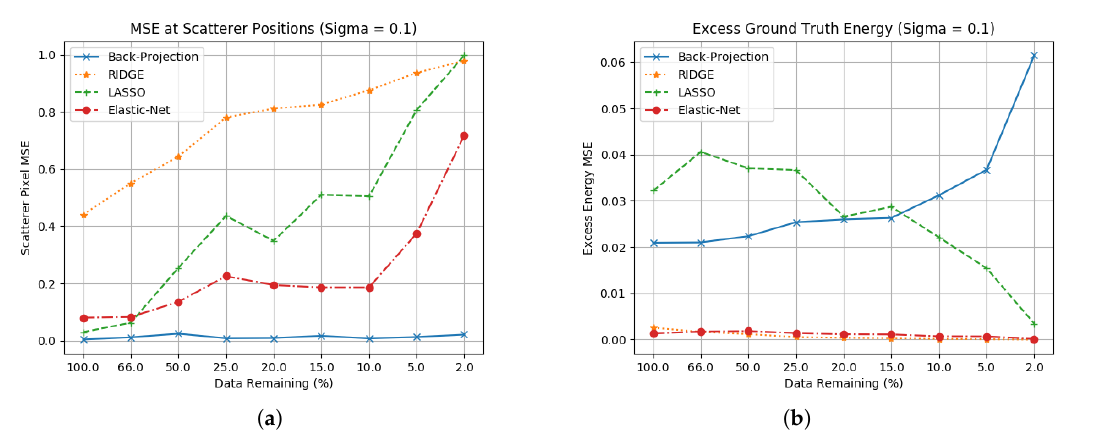
Figure 6. Ground truth estimation statistics for regularised linear regression methods with noise. ( a ) Scatterer location RCS error including noise ( σ = 0.1); ( b ) Excess energy including noise ( σ =